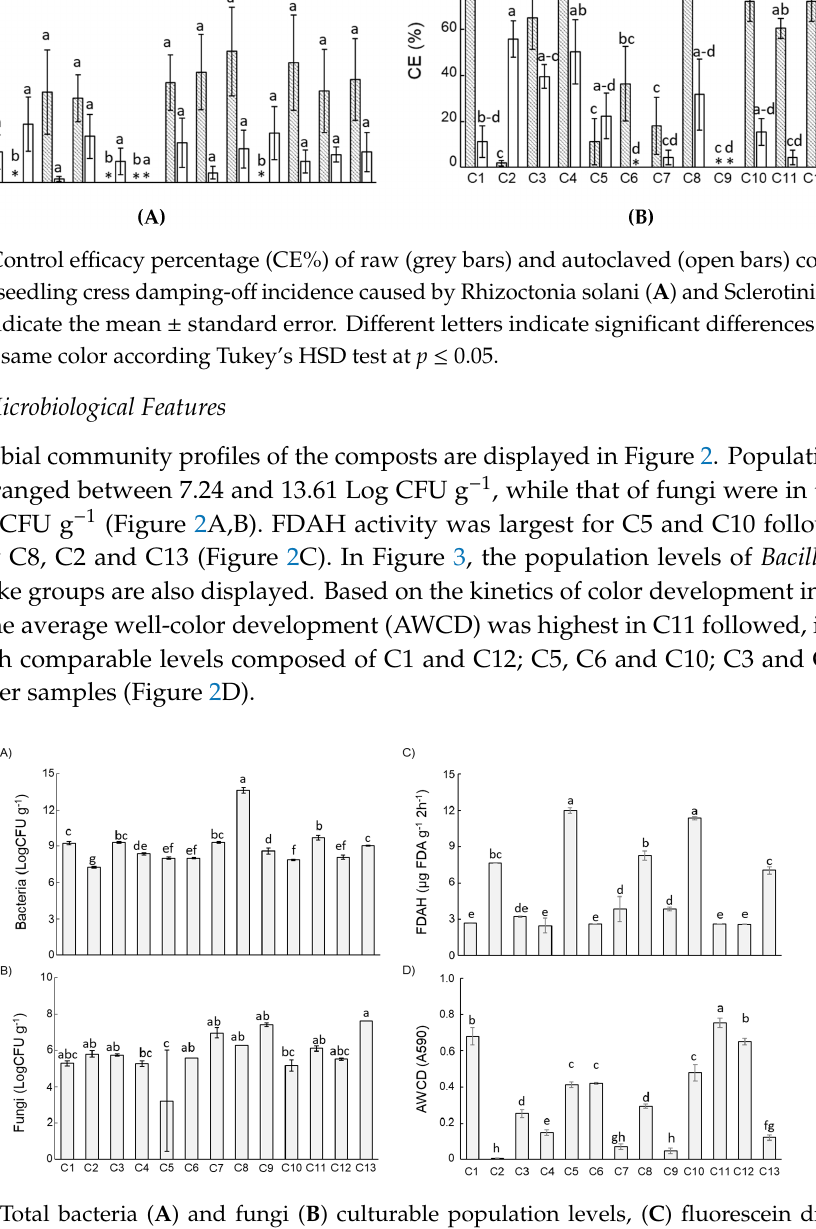
Figure 2. Total bacteria ( A ) and fungi ( B ) culturable population levels, ( C ) fluorescein diacetate hydrolysis (FDAH) and Biolog ® EcoPlate ™ ( D ) average well-color development (AWCD) in the on-farm green composts (C1–13). Bars indicate the mean ± standard deviation. Di ff erent letters indicate significant di ff erences according Tukey’s HSD test at p ≤